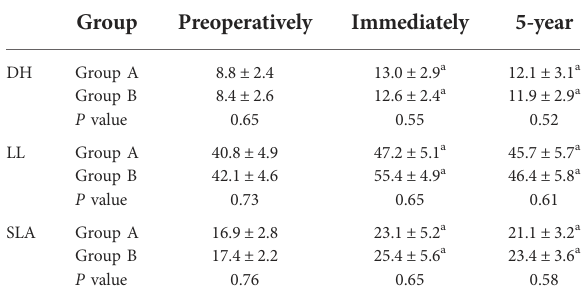
TABLE 4 Dh, LL and SLA of two groups.